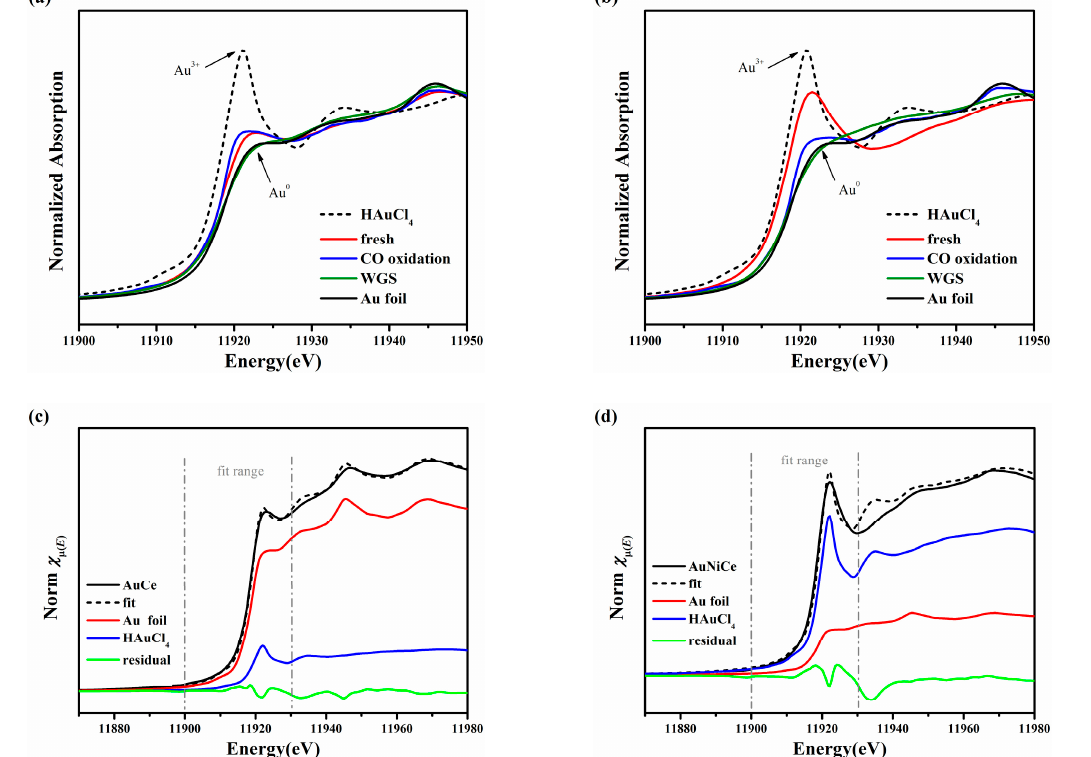
Figure 7. XANES profiles of AuNi/CeO 2 samples before and after different reactions: ( a ) AuCe ; ( b ) AuNiCe ; ( c ) linear combination fit on fresh AuCe ; ( d ) linear combination fit on fresh AuNiCe .